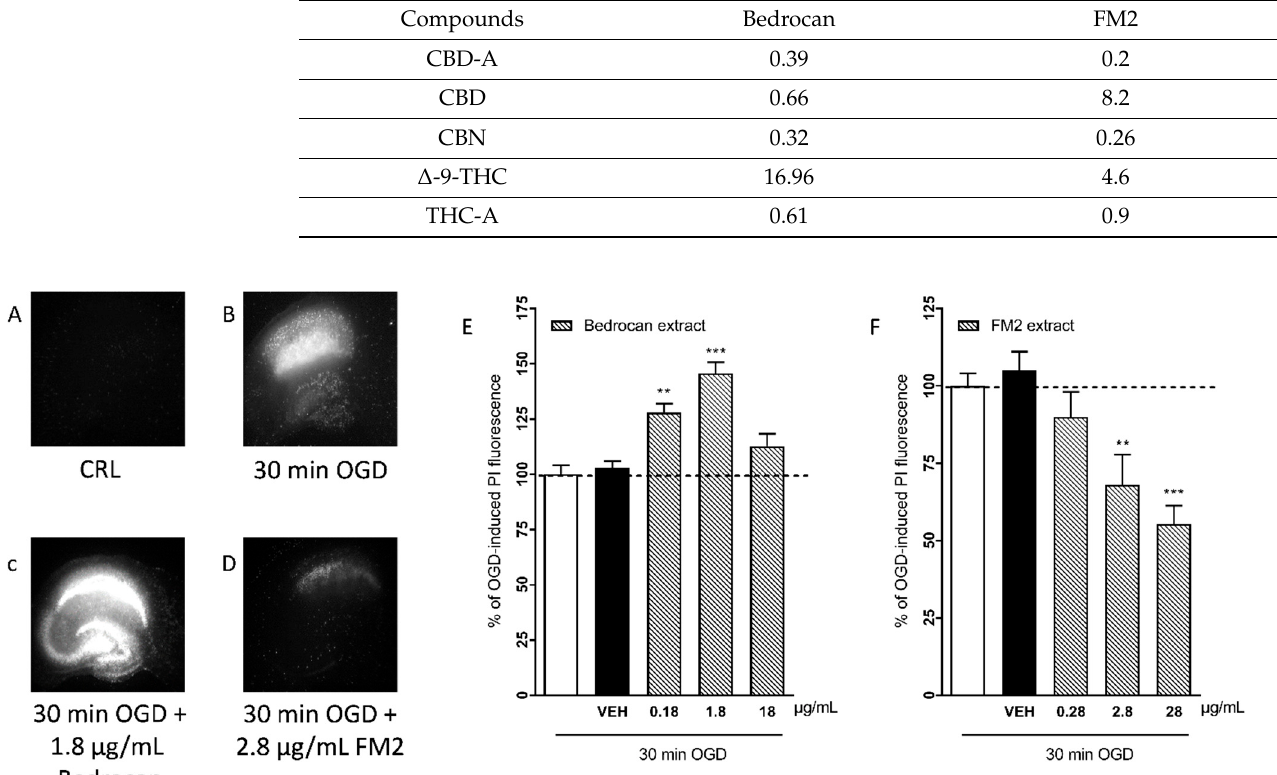
Figure 1. Qualitative and quantitative analysis of the effects of Bedrocan and FM2 extracts on OGD toxicity in rat organotypic hippocampal slices. OGD was applied for 30 min, and 24 h later, the damage in the CA1 region was assessed, measuring the intensity of PI fluorescence. Drugs were present in the incubation medium during OGD and the subsequent 24 h recovery period. ( A ): Hippocampal slice under normal conditions (background PI fluorescence), slice exposed to 30 min OGD displaying intense PI labeling in the CA1 subregion ( B ), CA1 damage induced by 30 min OGD was exacerbated by the presence of 1.8 g/mL of Bedrocan extract ( C ) CA1 damage induced by 30 min OGD was attenuated by the presence of 2.8 g/mL of FM2 extract ( D ). ( E ) The Bedrocan extract at the doses of 0.18 and 1.8 mg/mL significantly exacerbated CA1 injury in comparison to the damage caused by 30 min OGD alone, considered as 100%. ( F ) The FM2 extract dose-dependently attenuated CA1 injury. Data are expressed as percentage of OGD-induced PI fluorescence. Bars represent the mean ± SEM of at least 5 experiments run in quadruplicate. (** p < 0.01 and *** p < 0.001 vs. OGD; one-way ANOVA plus Dunnett’s test).